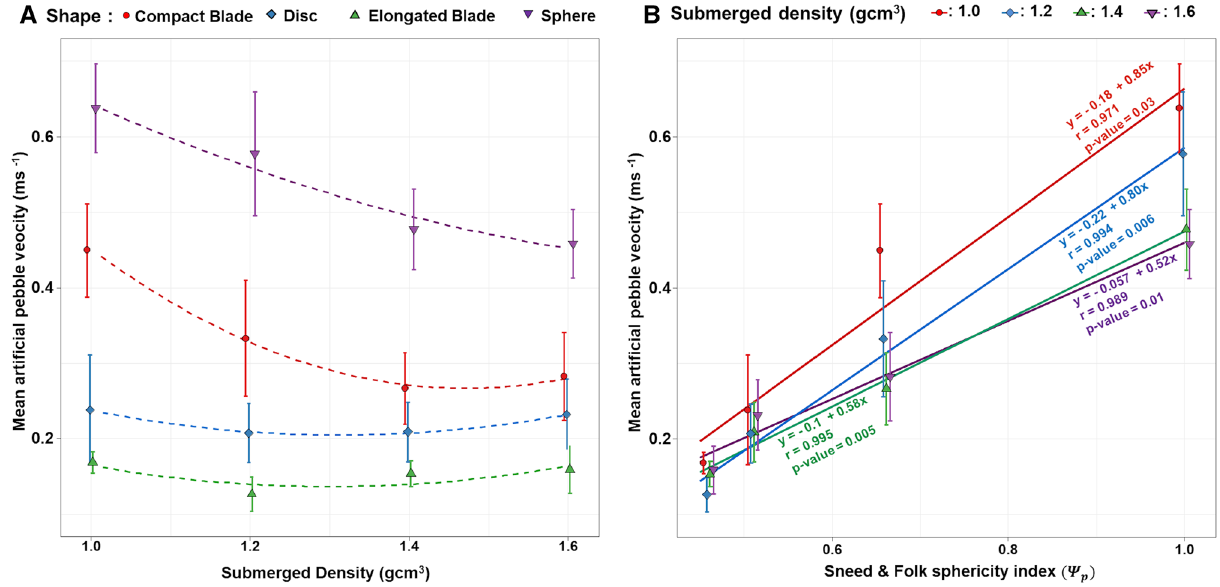
Figure 3. Mean velocity as function of density ( A ) and Sneed and Folk spherical index ( B ).